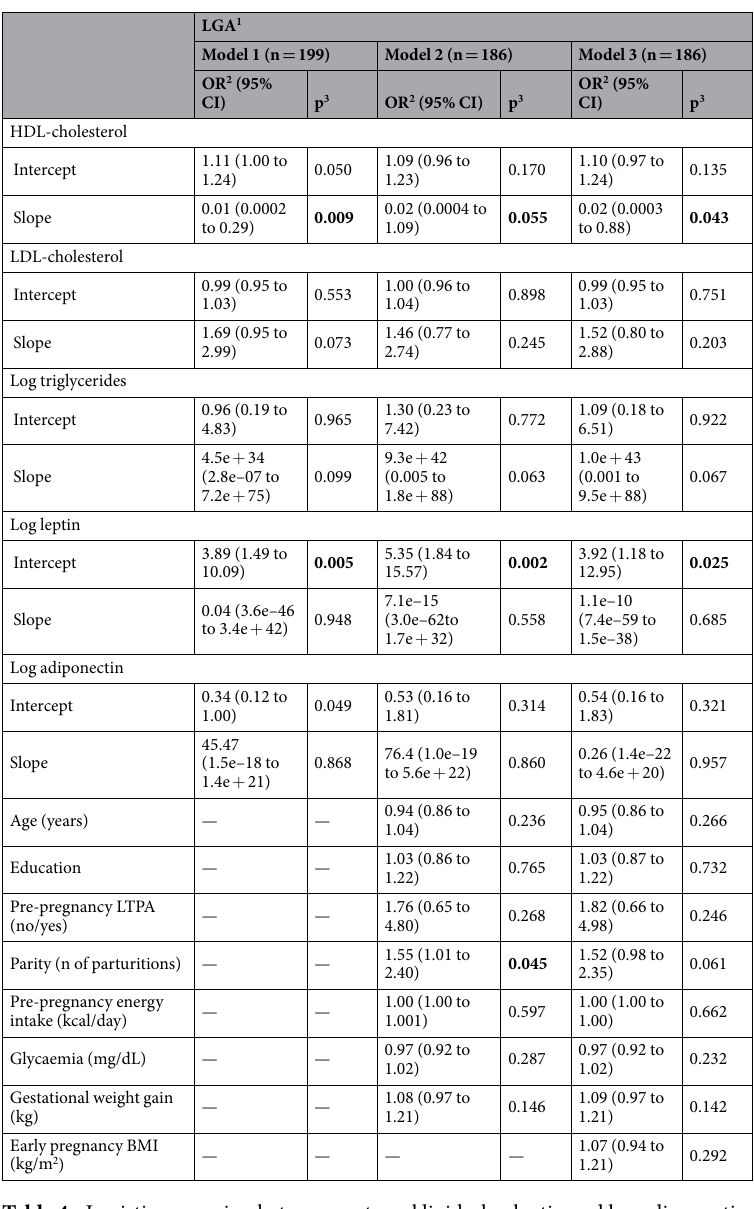
We further investigated the occurrence of multicollinearity in the full models using the variance inflation factor. We predicted residuals and fitted values of the outcomes for our final models. We checked normality of the residuals and constructed two-way scatter plots between the residuals and predicted values of BW to detect outlying observations and to check the assumption of constant variability of outcomes across values of exposure (homoscedasticity) and scatter patterns of the residuals 52 .